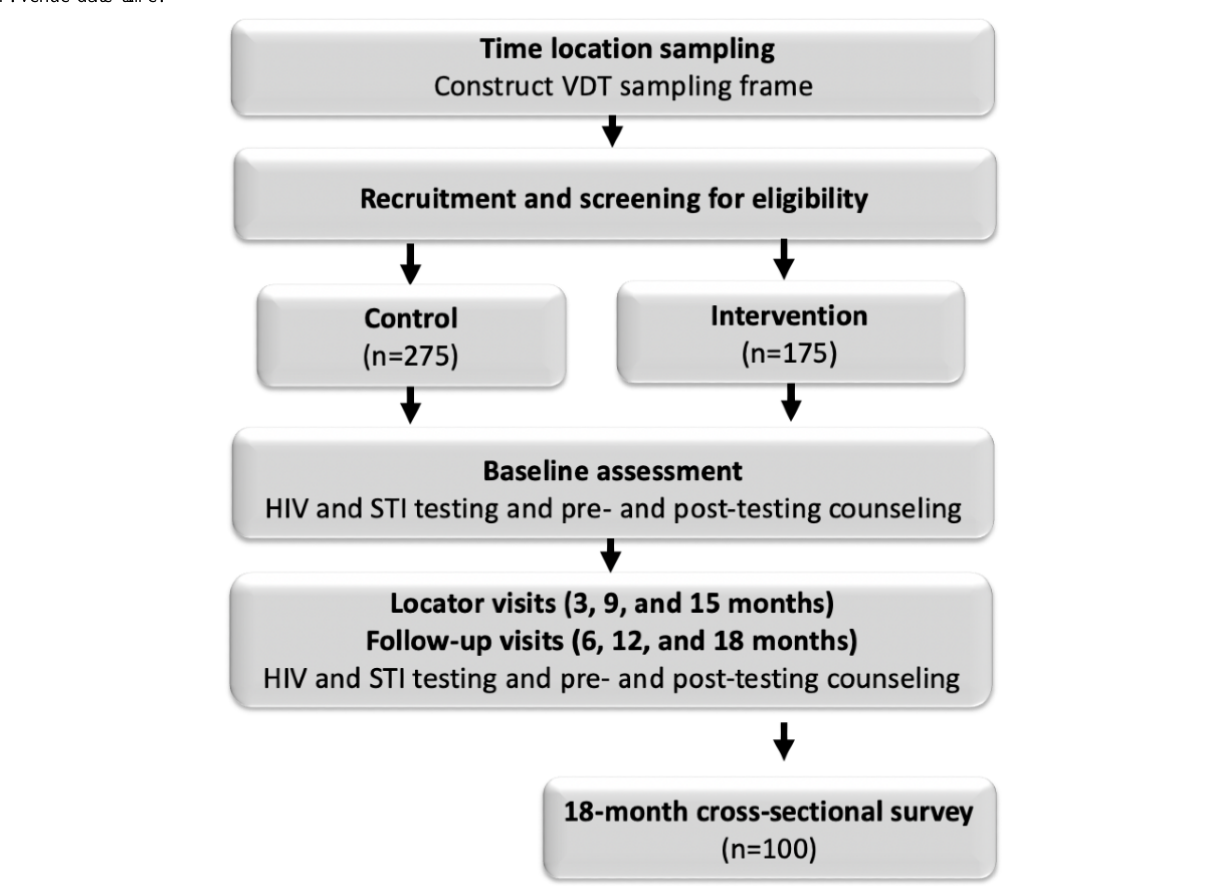
Figure 3. EMERALD (Enabling Mobilization, Empowerment, Risk Reduction, and Lasting Dignity) study flow. STI: sexually transmitted infection; VDT: